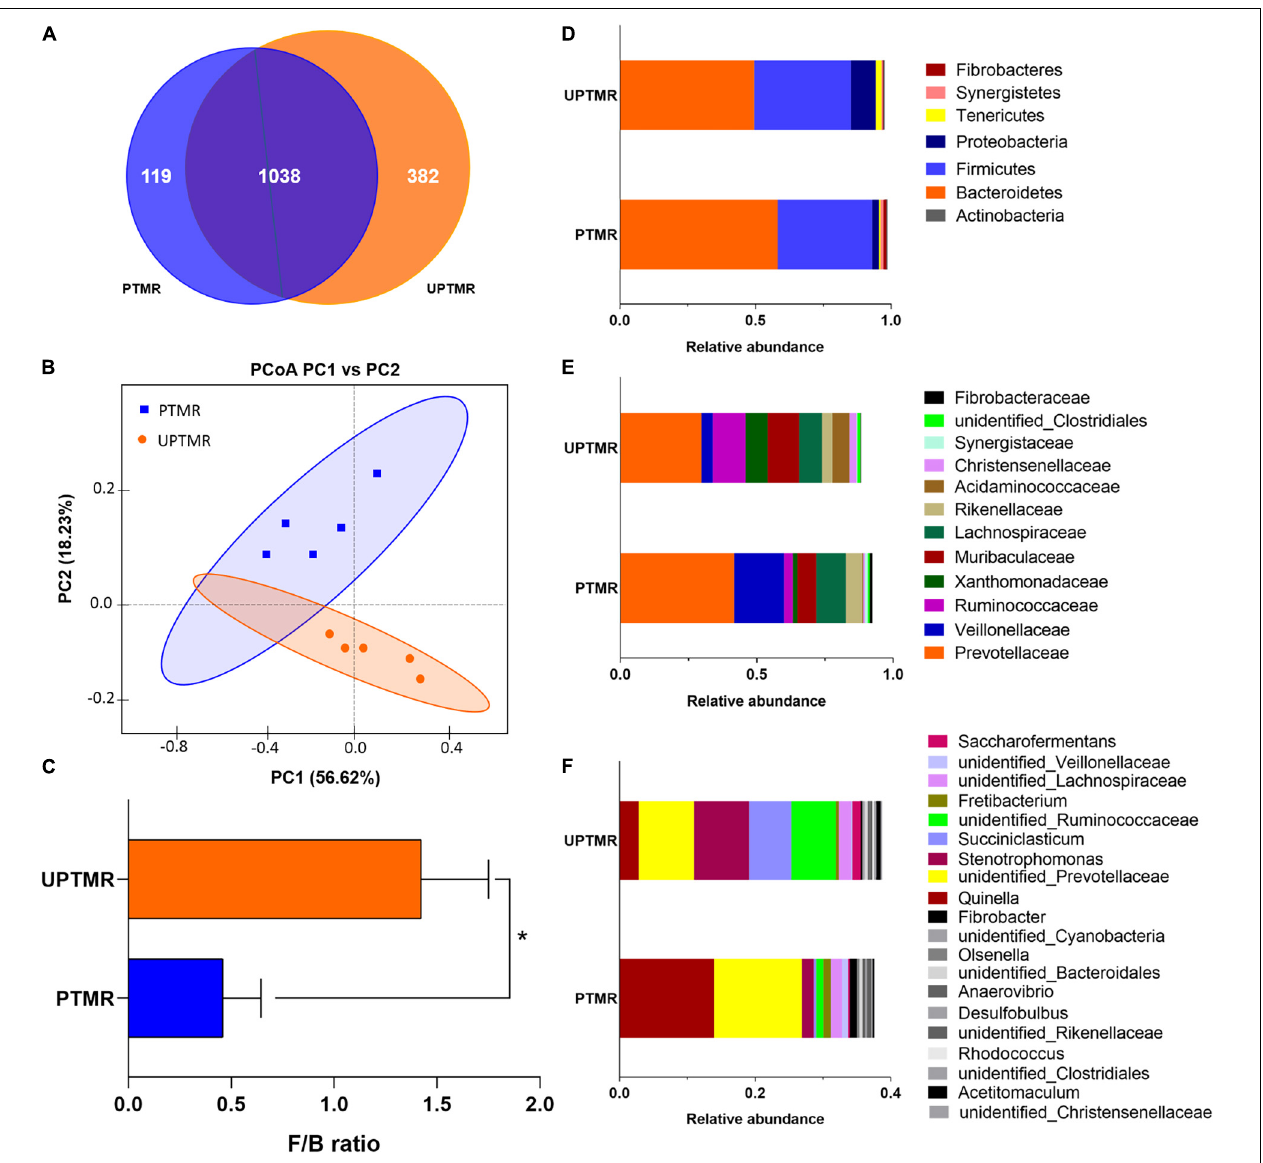
FIGURE 1 | The operational taxonomic unit (OTU) numbers, beta-diversity [principal coordinate analysis (PCoA) plot], and the relative abundances at the phylum, family, and genus levels of the ruminal microbiota of lambs fed pelleted total mixed ration (PTMR) or unpelleted PTMR (UPTMR) diet. (A) Venn diagram of OTUs in the ruminal microbiota. (B) Principal coordinate analysis (PCoA). (C) The ratio of Firmicutes and Bacteroidetes . The relative abundances at the (D) phylum, (E) family, and (F) genus levels of ruminal microbiota of lambs fed PTMR or UPTMR.